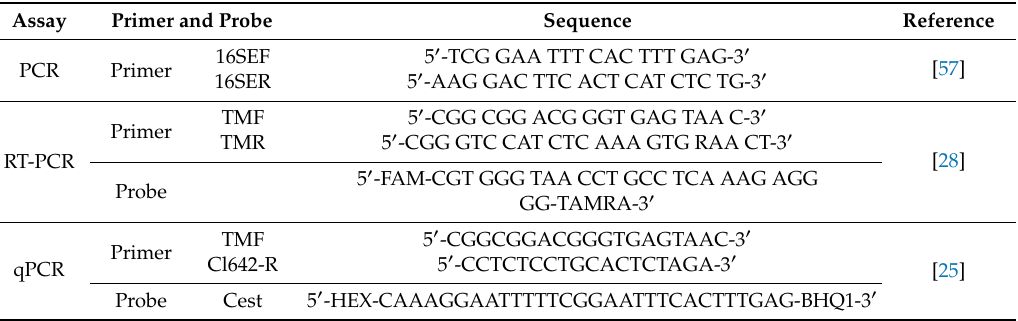
Table 2. Primers and probes used to detect Cl. estertheticum